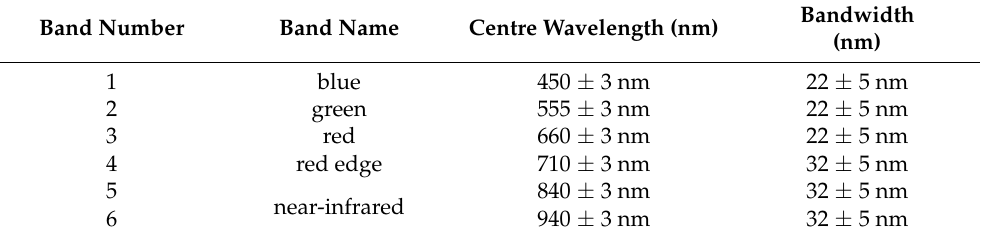
Table 1. The selected spectral